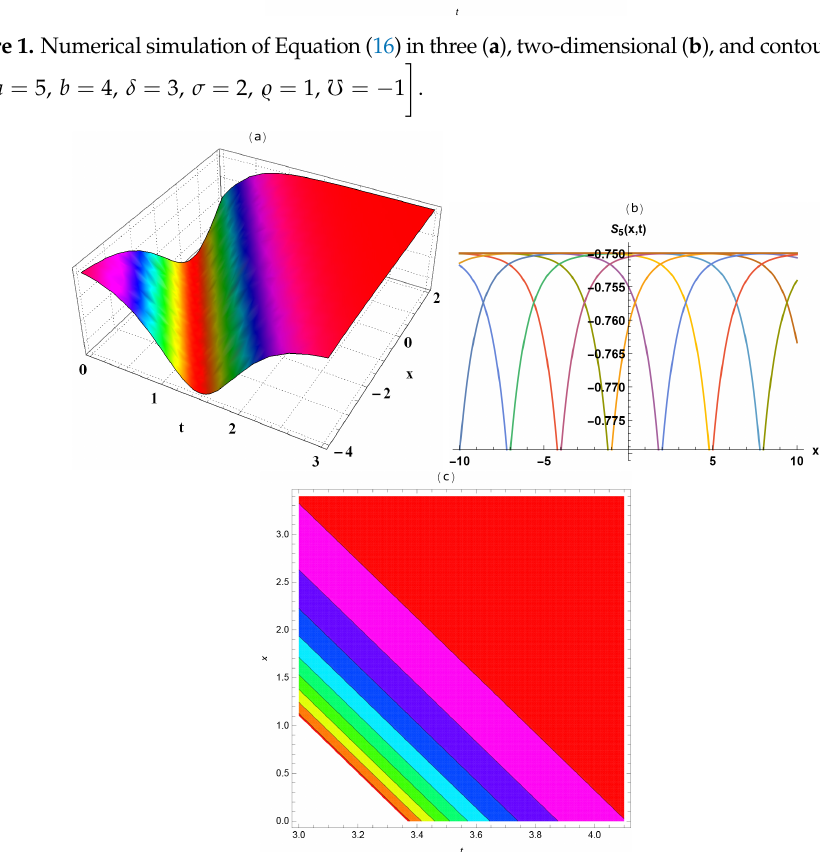
Figure 2. Numerical simulation of Equation (20) in three ( a ), two-dimensional ( b ), and contour (cid:20) a = 2, b = 4, δ = 5, σ = 6, (cid:36) = 1, ( c ) sketches for